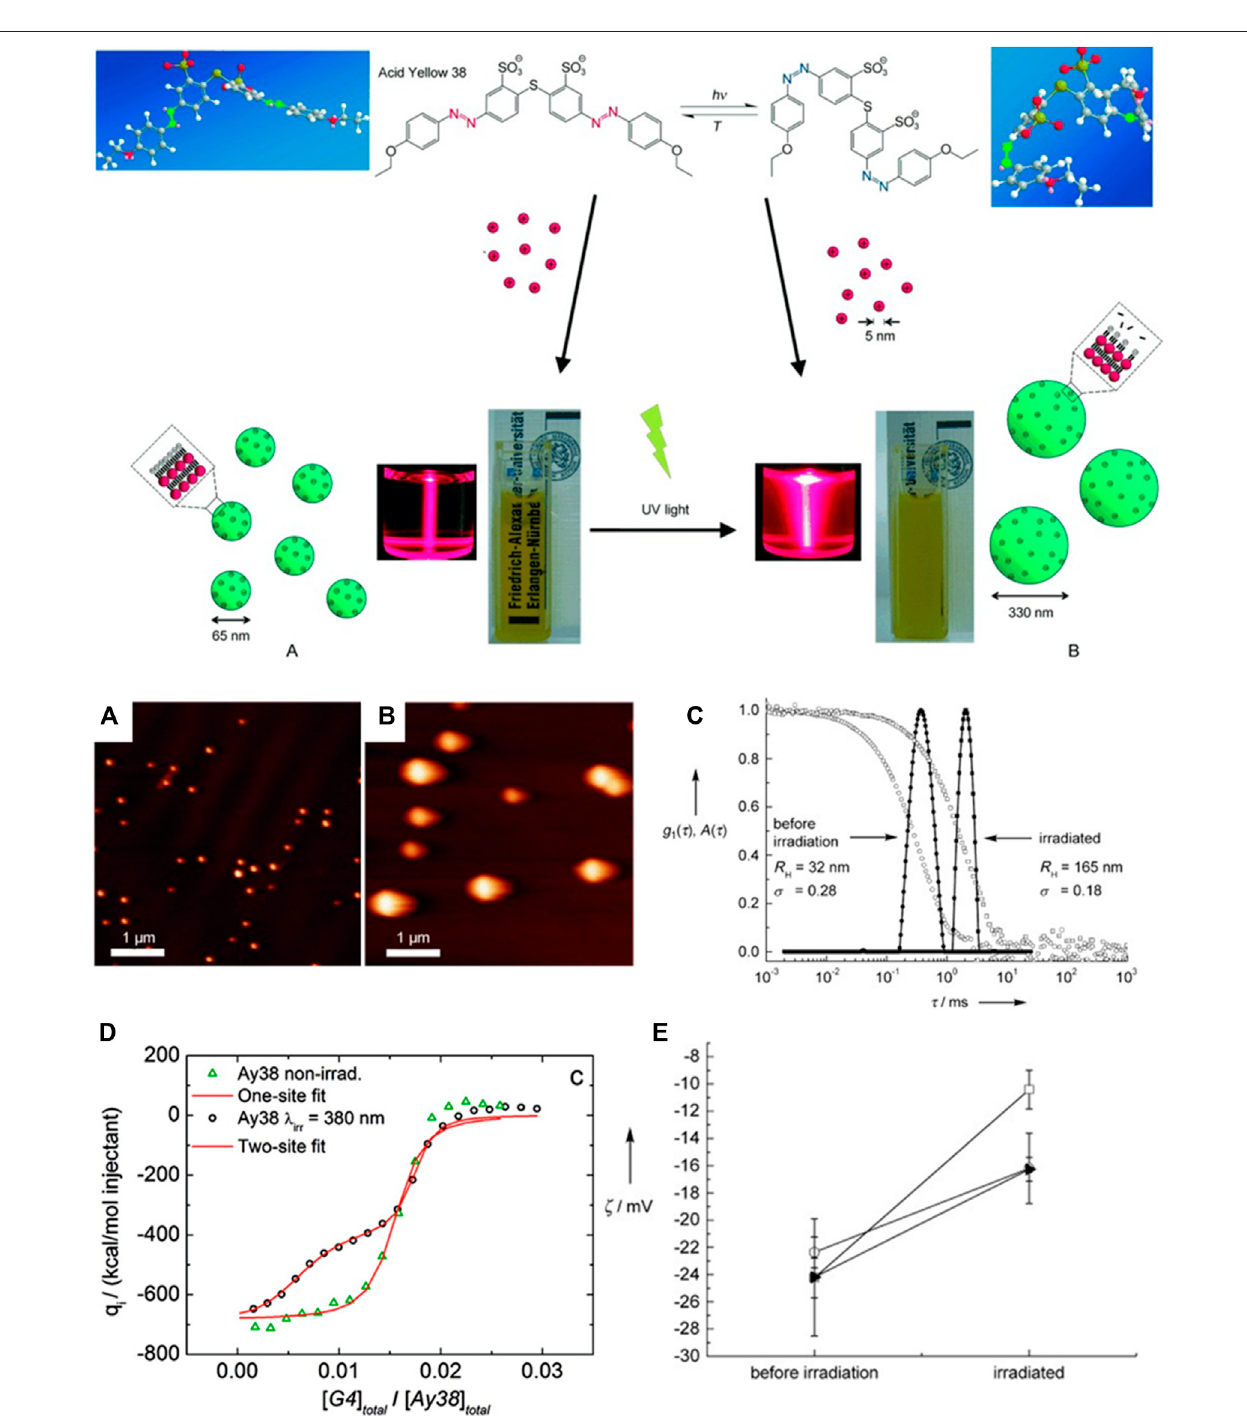
FIGURE 19 | A light-switchable electrostatically self-assembled system with photo addressable particle size; top: schematic representation. Starting from a divalent anionic azobenzene dye and cationic dendrimeric macroions, self-assembled nanoparticles result (A) , which grow in size upon irradiation with UV light (B) ; middle:AFM (A) beforeand (B) afterUVirradiationand (C) correspondingDLSforaloadingratiol (cid:1) 4.5; (D) Isothermaltitration calorimetryrevealingthedifferentbinding enthalpies of the cis and the trans dye isomer; (E) ζ -potential for dendrimer – dye assemblies before and after irradiation for different loading ratios con fi rming the charge density control of the particle size (Willerich and Gröhn, 2010; Willerich and Gröhn, 2011b). Reprinted with permission. Copyright © 2011 American Chemical Society and © 2010 WILEY-VCH Verlag GmbH and Co. KGaA, Weinheim.